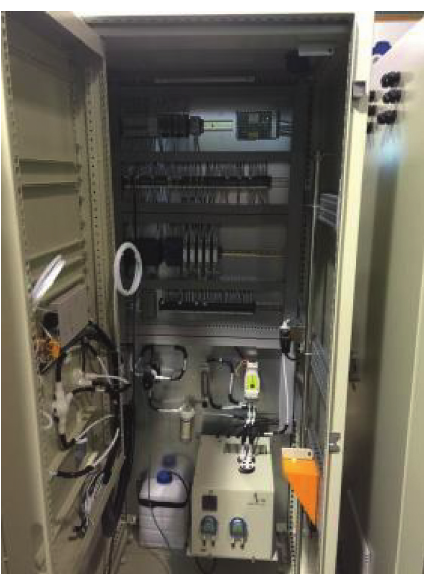
Figure 2: Photograph of the preprocessing